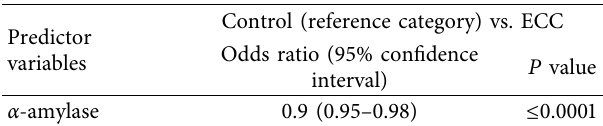
Table 2: 8 th step of stepwise logistic regression analysis identifying predictors of ECC.